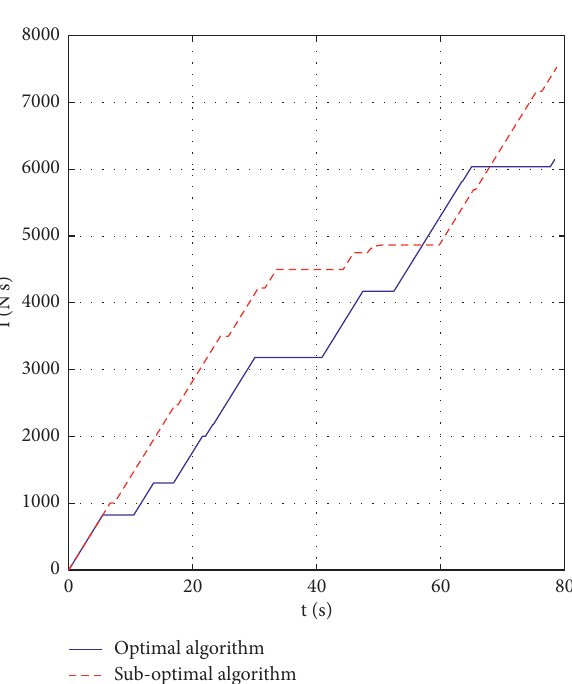
Figure 13: Curve of I